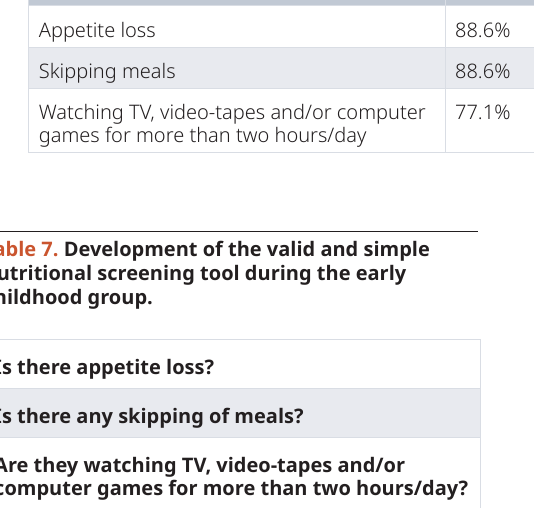
Table 6. Validation with anthropometric measures of the questions which have highest sensitivity, specificity and accuracy with the